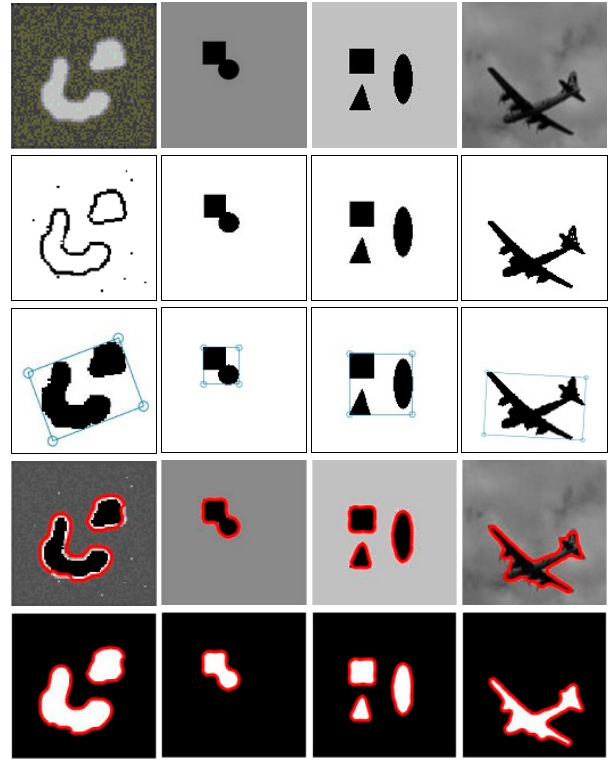
Figure 5. Improved method validation experiment. The first row: Original sonar images. The second row: Clustering analysis of images. The third row: Initial evolution contours after removing the discrete points. The fourth row: Our improved level set method. The fifth row: Extraction of target contour.